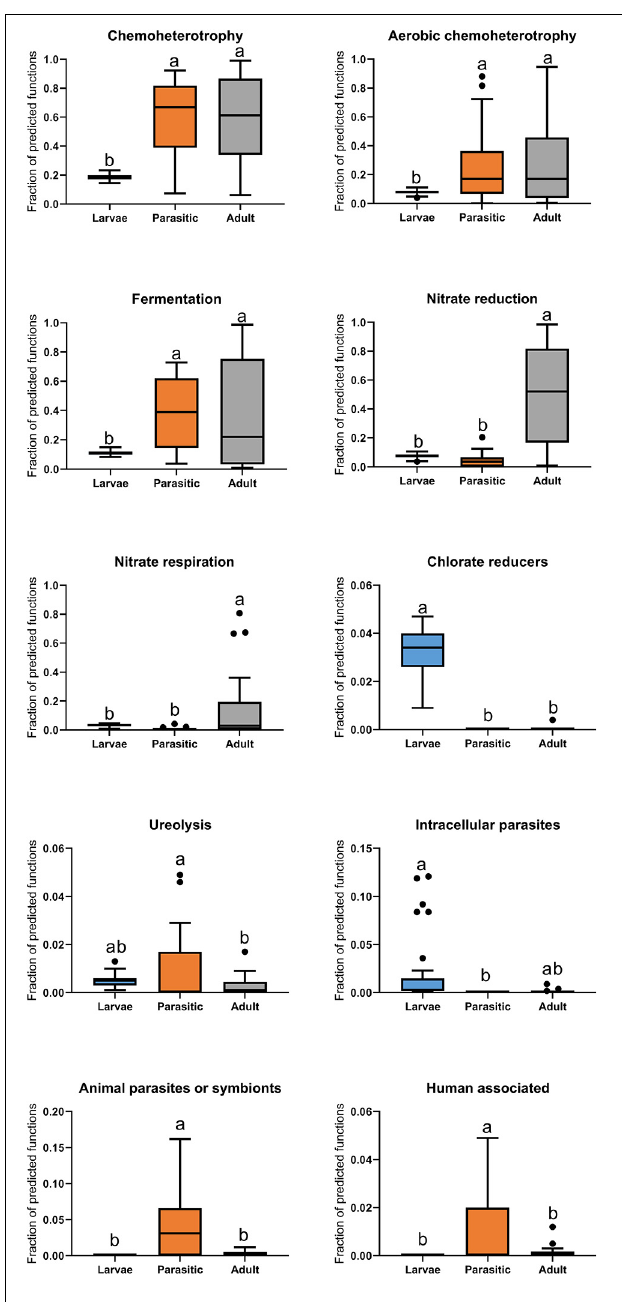
FIGURE 6 | Boxplot of predicted functions based on FAPROTAX database. Tukey’s HSD post hoc test. On the boxplots, the centerlines show the medians, the bottom and upper limits indicate the 25th and 75th percentiles and the whiskers encompass the 10–90 percentile range; significant differences ( p < 0.05) illustrated by different letters above